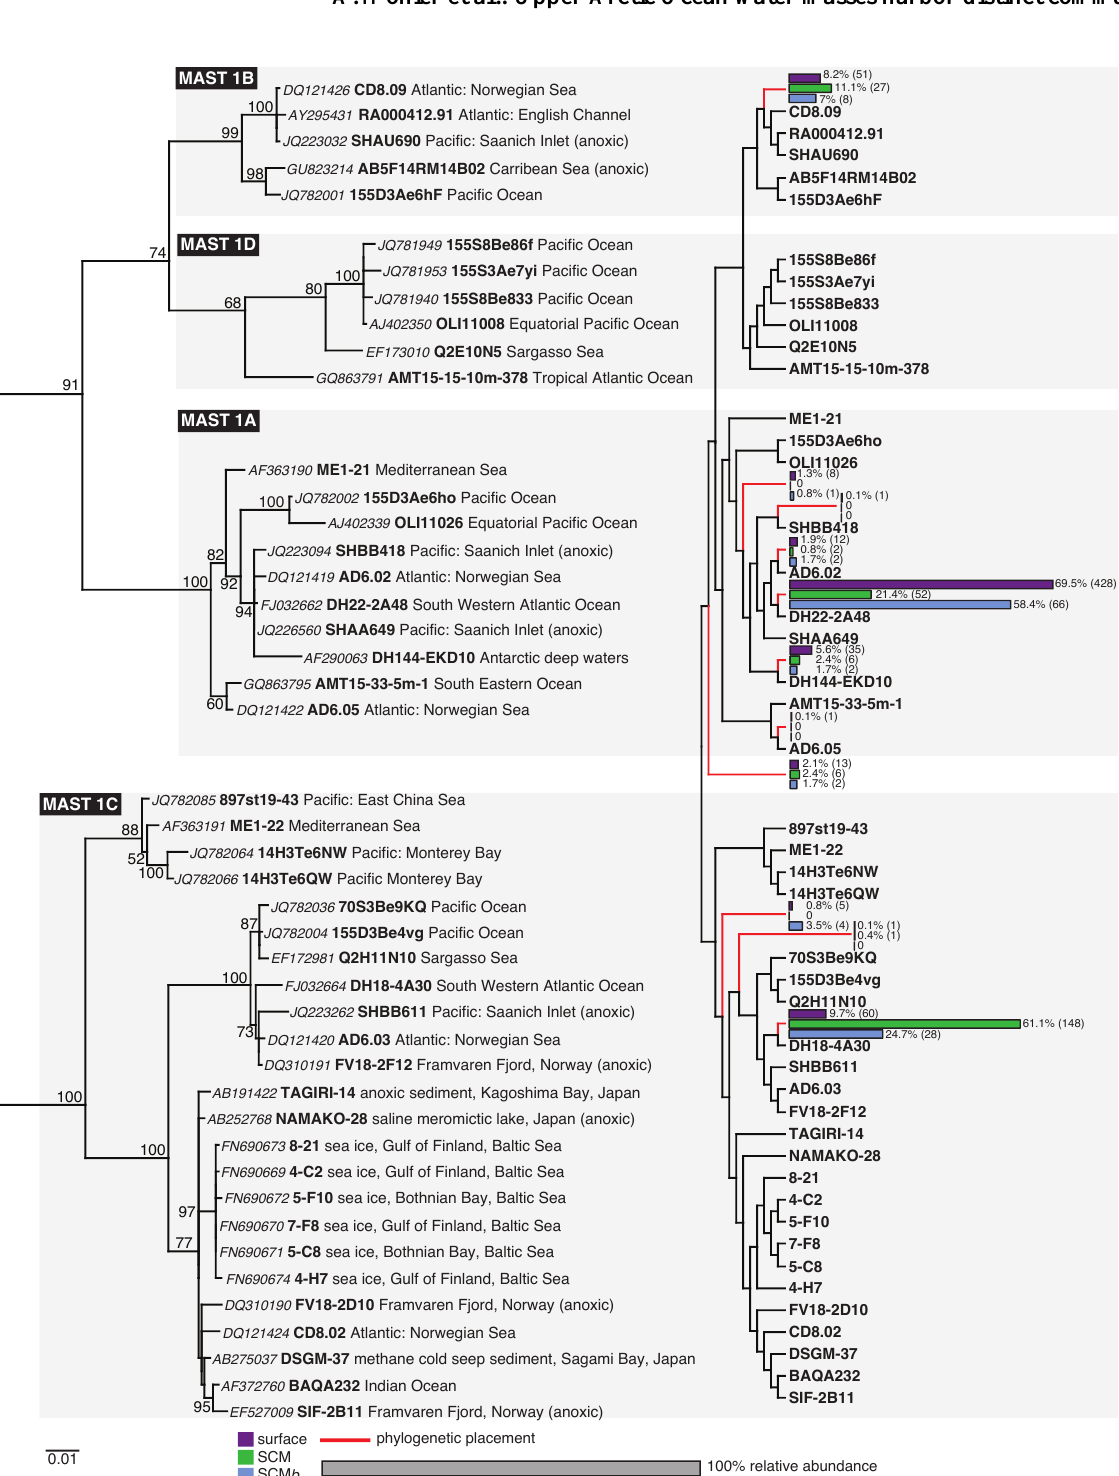
Figure 5 Fig. 5. Phylogenetic mapping of MAST-1 reads from the Beaufort Sea. MAST-1 reference phylogenetic tree (right phylogram) was recon- structed using maximum-likelihood, and node statistical supports were computed using 1000 rapid bootstrap replicates using RAxML. Reads classified as MAST-1 were mapped onto the MAST-1 reference tree using RAxML evolutionary placement algorithm (left cladogram). Phy- logenetic placements are indicated by red branches. Distributions of phylogenetic placements are indicated by color bars (Purple, green and blue bars represent surface, SCM and SCM b depths, respectively). First number corresponds to percent of total depth and second number is total number of a given depth